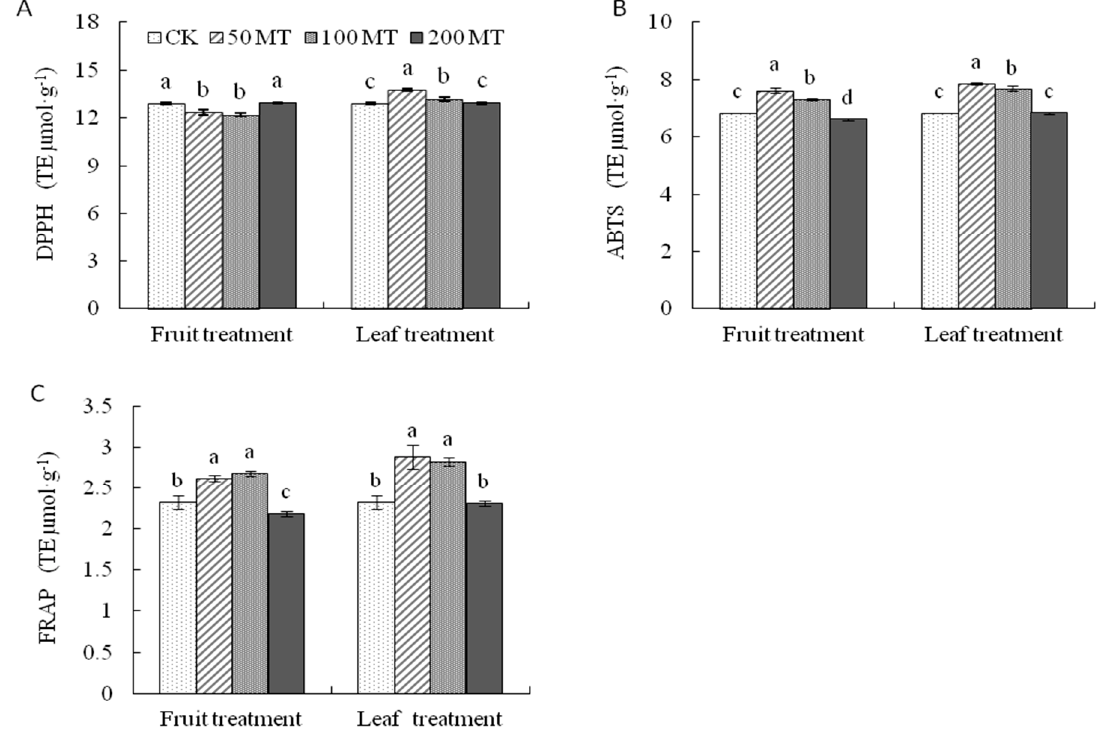
Figure 6. Antioxidant activity determined by ( A ) 2,2-diphenyl-1-picrylhydrazyl (DPPH), ( B ) 2,2 ′ -azinobis (3-ethylben zothiazoline-6-sulfonic acid) (ABTS), and ( C )ferric reducing antioxidant power (FRAP) assays of Hongdeng sweet cherry after exogenous melatonin application. Data are shown as mean ± SE, with five biological replicates, different letters indicate significant differences at p < 0.05 level.